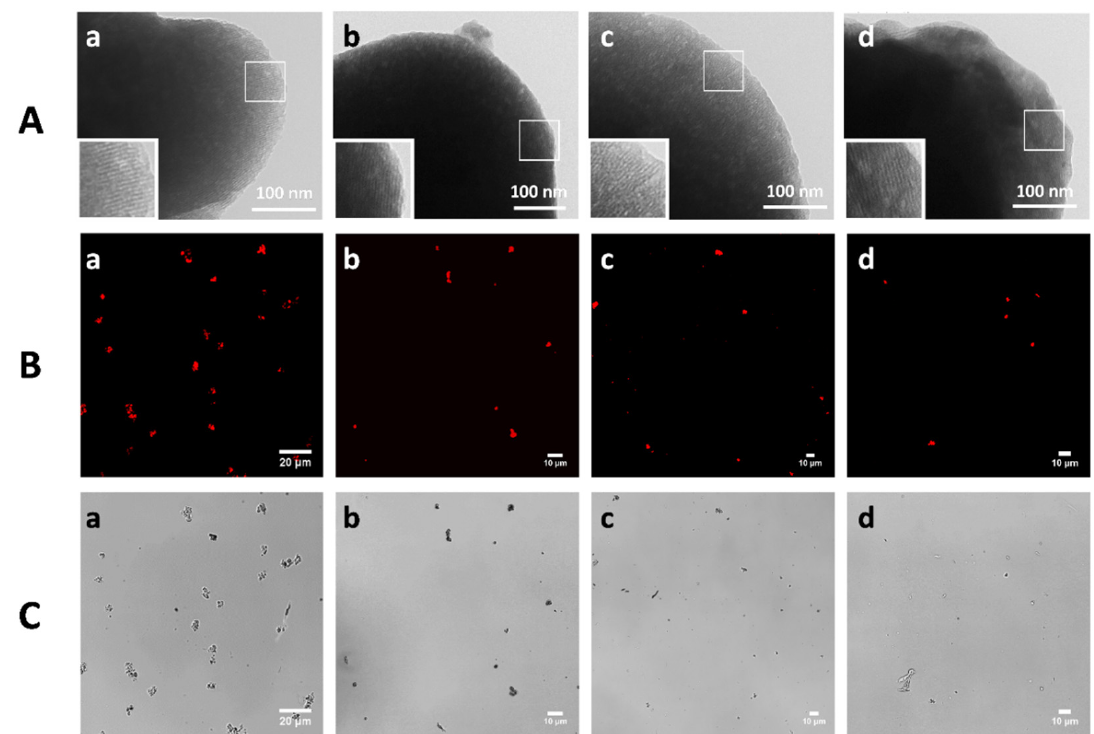
Figure 5. TEM ( A ), CLSM ( B ) and CLSM transmitted light ( C ) micrographs of M41-RhB-L suspended in water ( a ), and in the different simulated saliva ( b ), gastric fluid ( c ) and intestinal fluid ( d ), showing no degradation of the structured-material. TEM micrographs ( A ) were acquired after collecting, washing and drying the particles several times.